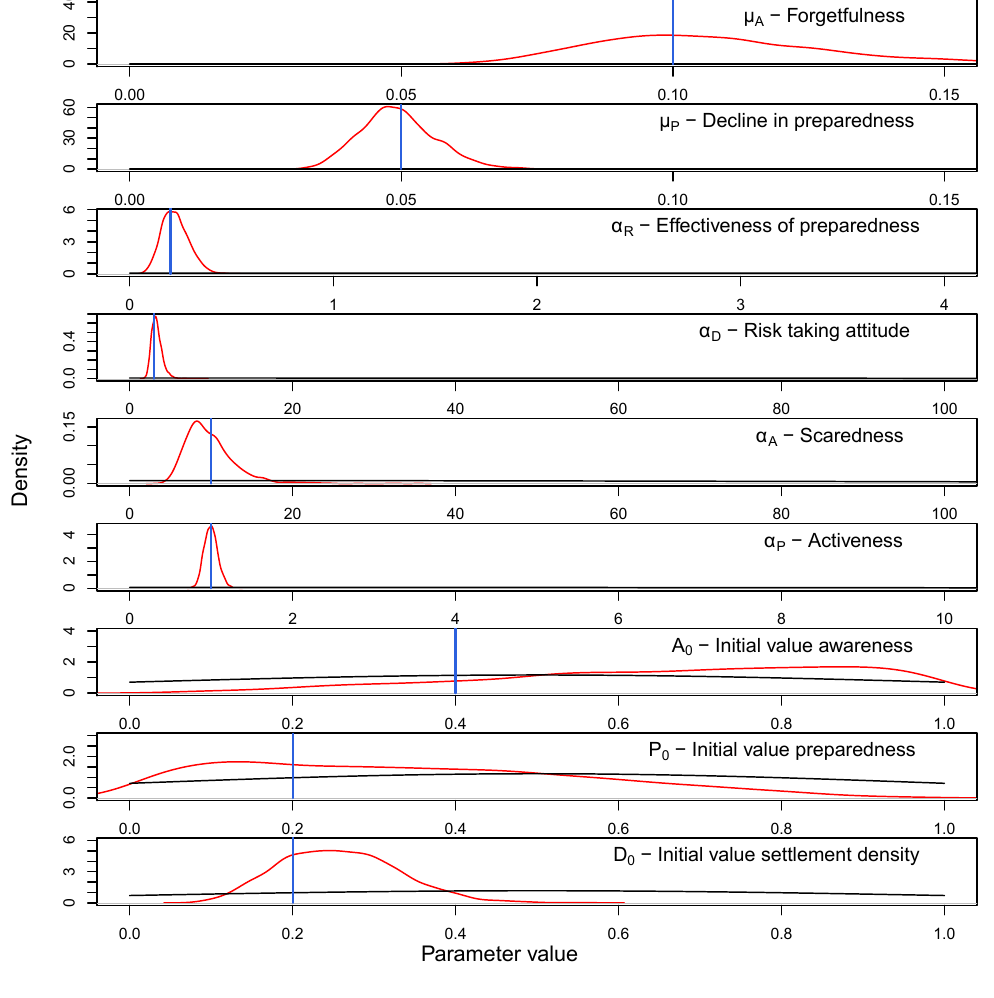
Figure 2. Prior (black) and posterior (red) distributions of the parameters. The “real” parameters to be estimated are represented by the blue vertical lines (see Table 2 for their